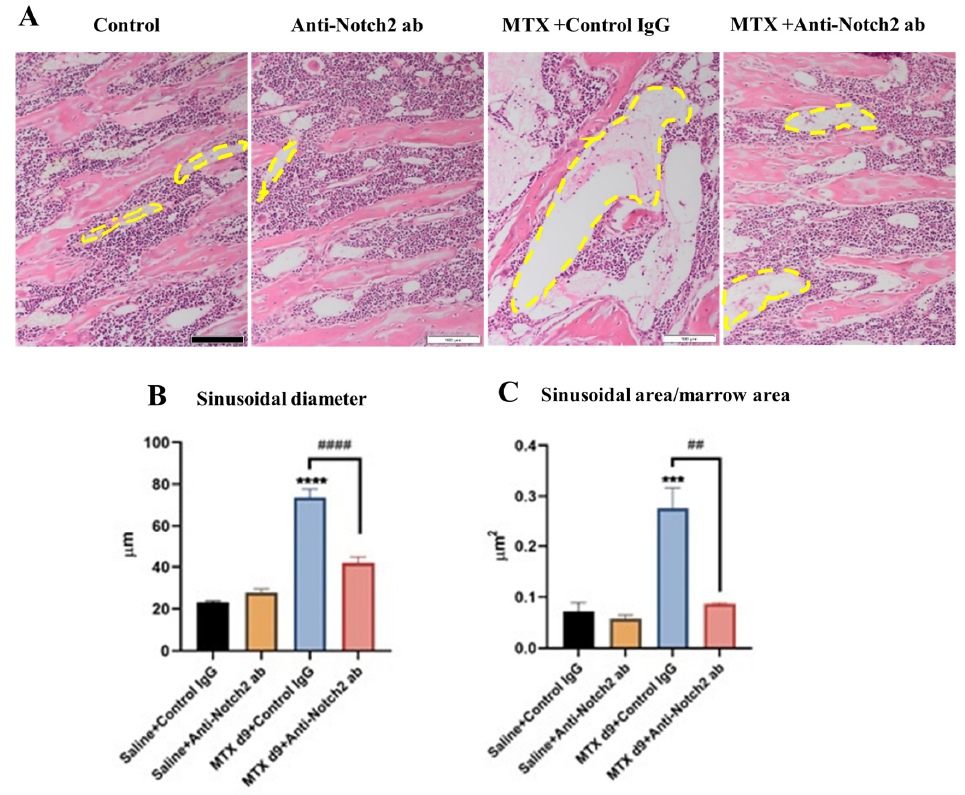
Figure 2. Effect of MTX or MTX+Anti-Notch2 antibody (ab) treatment on bone marrow sinusoid dilation in rats (histological analyses). ( A ) Representative tibial sections with H&E staining from different treatment groups, showing treatment effects on bone marrow sinusoids (indicated by yellow dash lines). Scale bar is 100 µ m. ( B ) BM sinusoidal diameters at different treatment groups. ( C ) Treatment effects on sinusoidal area per bone marrow area. *** p < 0.001 and **** p < 0.0001 compared to control group; ## p < 0.01 and #### p < 0.0001 compared with MTX+Control IgG-treated group. All the measurements are expressed as mean ±